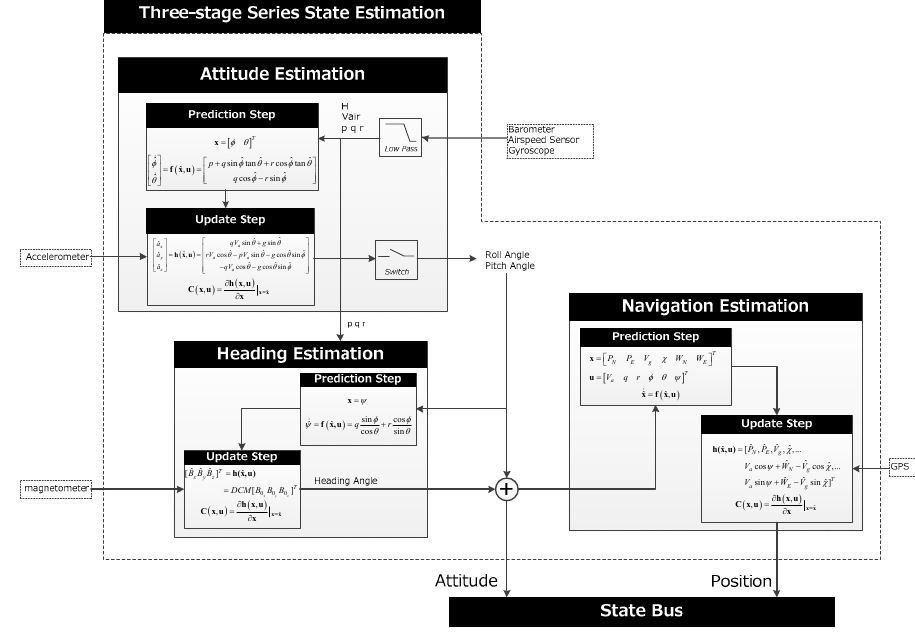
Figure 4. Three ‐ stage series state estimation algorithm structure. Figure 4. Three-stage series state estimation algorithm